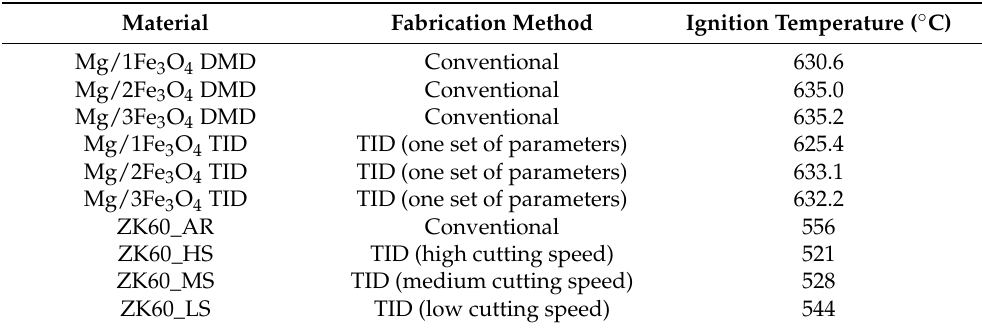
Table 2. Ignition temperatures of Mg materials undergoing both conventional and TID method processing